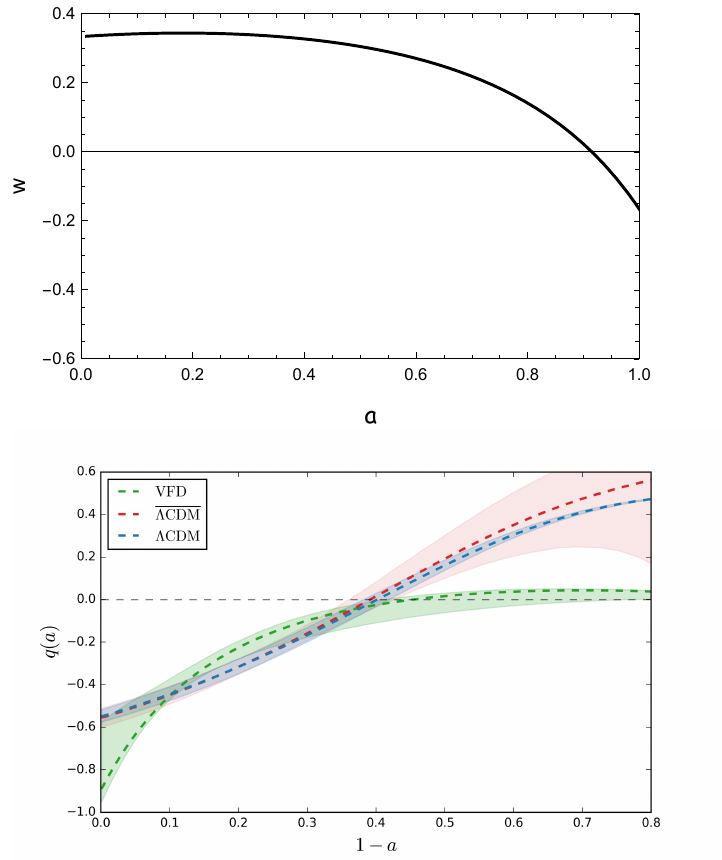
Figure 2. ( Upper panel ). Equation of the vacuum state in dependence on the universe scale factor a . ( Lower panel ) Deceleration parameter q ( a ) and the corresponding dispersion channels for the VFD model (24) and two versions of Λ CDM